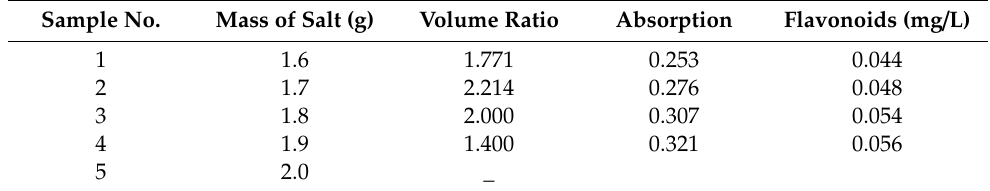
Table 2. E ff ect of the mass of salt on flavonoid extraction. Table 2. Effect of the mass of salt on flavonoid extraction. Sample No. Sample No.